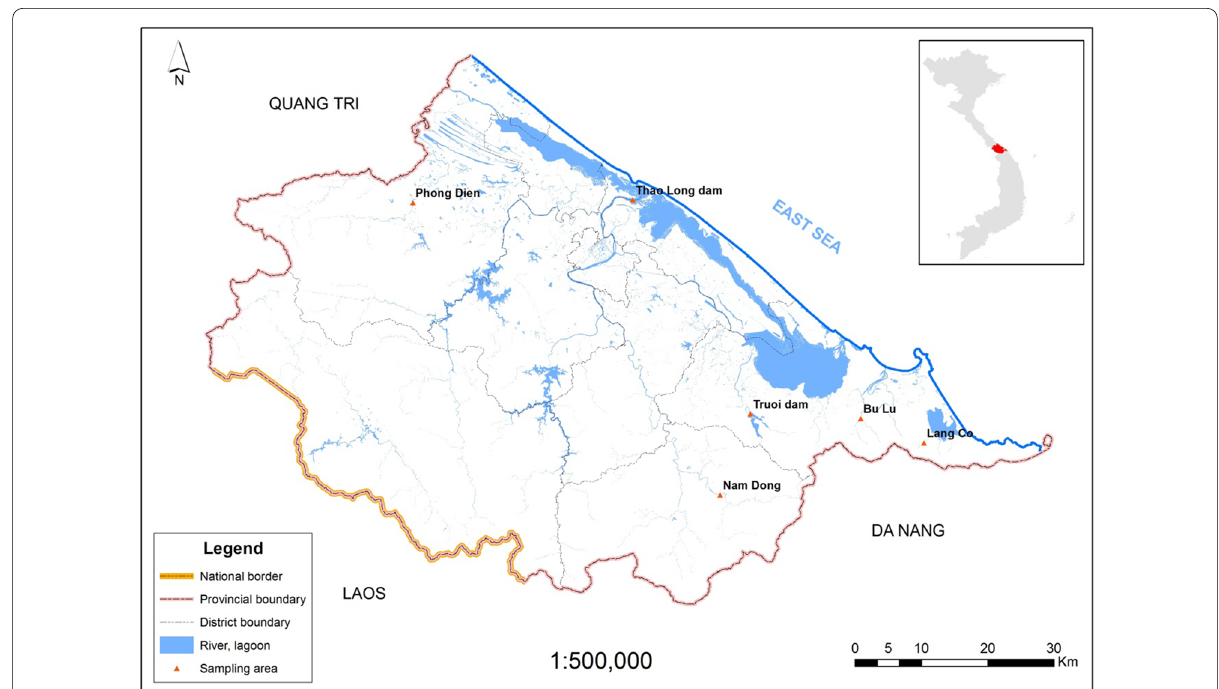
Fig. 1 Sample sites of Anguilla marmorata in Thua Thien Hue, Viet